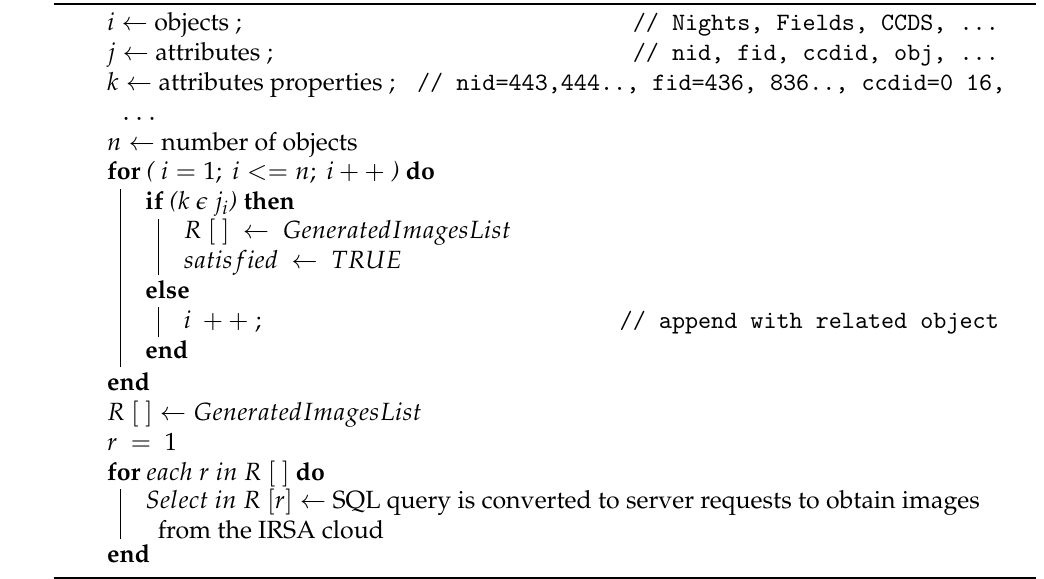
Algorithm 1: Query Workflow across the multiple data